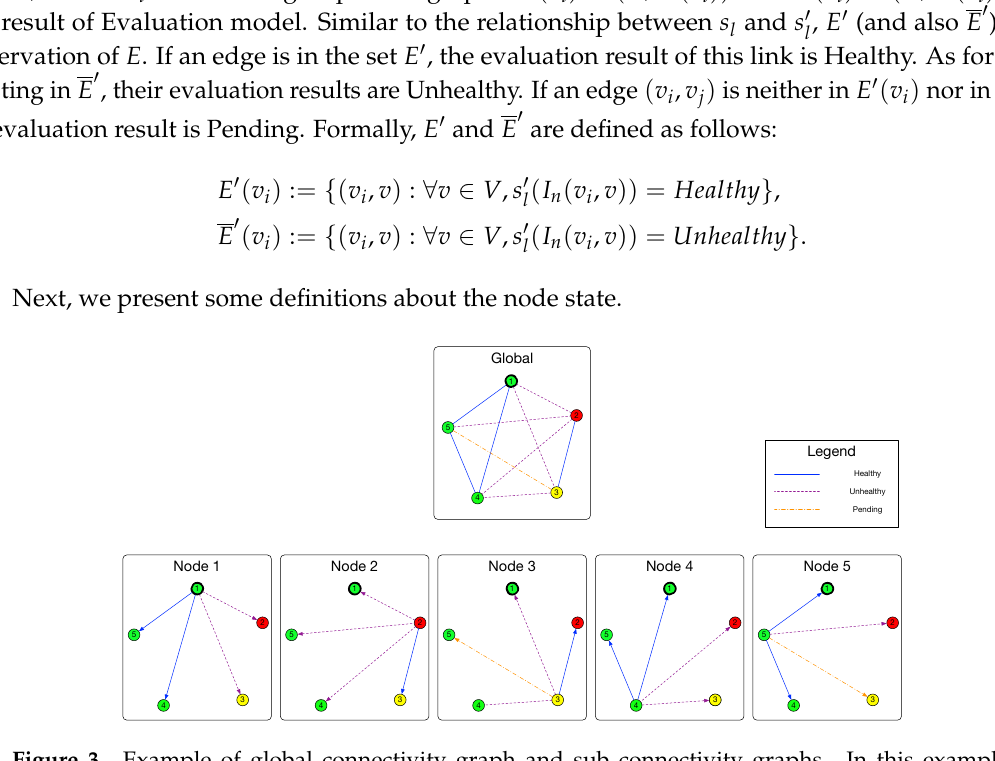
Figure 3. Example of global connectivity graph and sub connectivity graphs. In this example, (cid:48) ( E (cid:48) ( v 3 ) = { ( v 3 , v 2 ) } and E v 3 ) = { ( v 3 , v 1 ) , ( v 3 , v 4 )